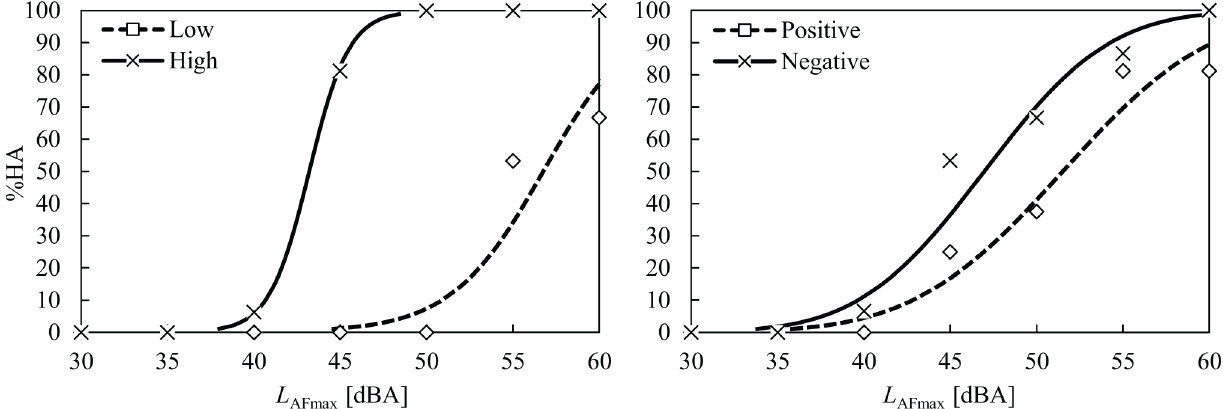
Fig 8. Percentage of highly annoyed (%HA) for the low ( □ ) and high (×) noise-sensitivity groups and positive ( □ ) and negative (×) attitude groups as a function of noise level. Probit regression curves are also presented for both groups.